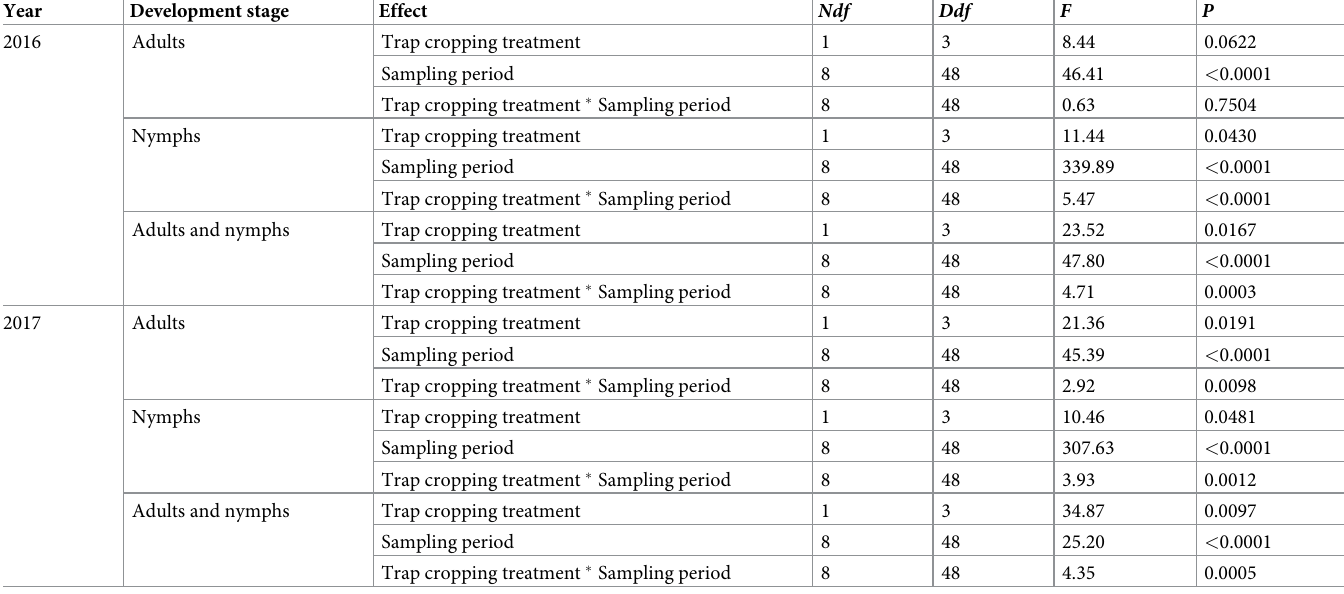
Table 1. Mixed effect linear model (MIXED) analysis of population abundance of Lygus pratensis in cotton fields with and without sunflower strips, during 2016 and